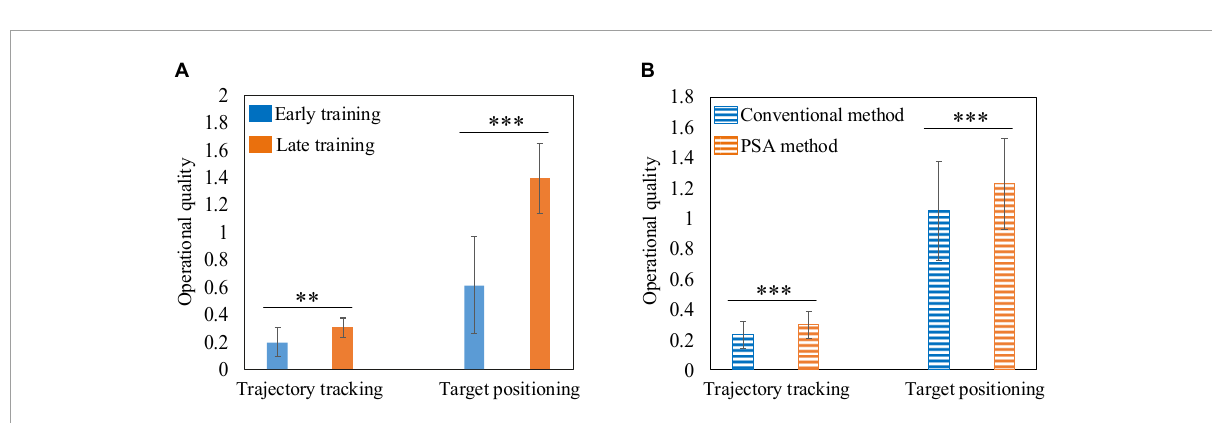
FIGURE14 (A) The comparison histogram of operational quality between early and late training. (B) The comparison histogram of operational quality between the conventional method and the PSA method. ∗∗ Represents p < 0.01, and ∗∗∗ represents p <